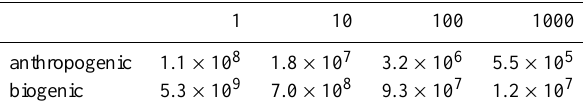
Table 2. Henry’s law constants H ∗ (Matm − 1 ) for different volatil- ity bins ( C ∗ in µgm − 3 , at 298K) as derived in Hodzic et al. (2014a). Shown are averaged values used for anthropogenic and biogenic semi-volatile mixtures. All water solubilities are used with a